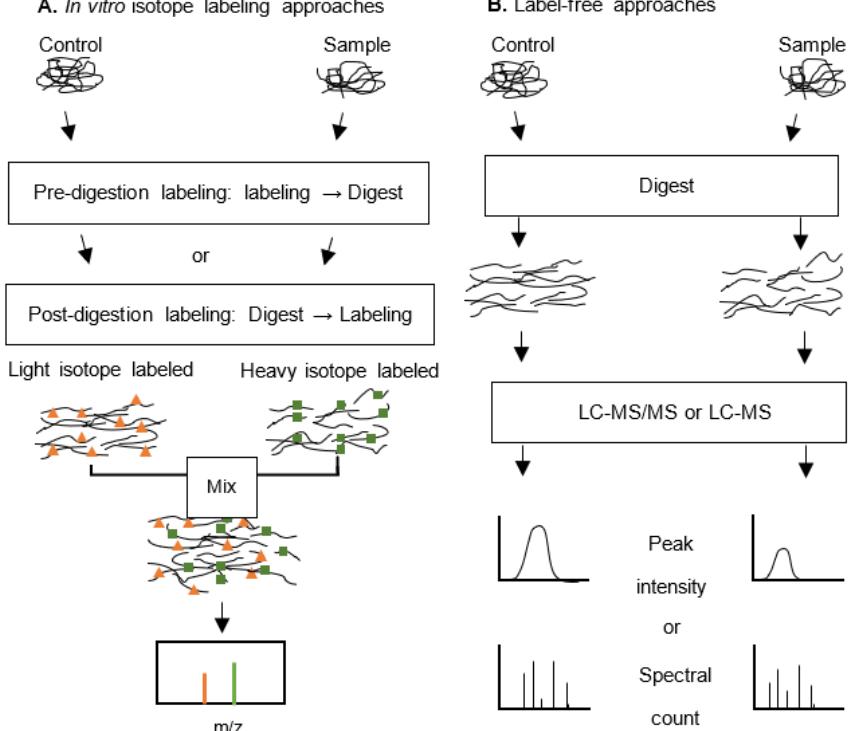
Figure 1. Overview of proteomic quantification approaches. ( A ) Stable isotope labelling method. After labelling with a stable isotope of different molecular mass, the samples are combined and analysed by mass spectrometry. The relative quantification is achieved through calculating the intensity ratio of labelled peptide pairs/groups [mass to charge ratio ( m / z )]. ( B ) Label-free quantification approach. Samples are digested and subject to liquid chromatography–tandem mass spectrometry (LC-MS/MS) analysis individually. The subsequent quantification is based on the comparison of peak intensity or spectral count of the peptide or the protein. The stable isotope labelling allows for more accurate quantification of protein expression, whereas label-free methods could be employed to avoid certain drawbacks of the former, such as inefficient labelling, difficulty in the analysis of low abundance peptides, and sample number limitation (cf.